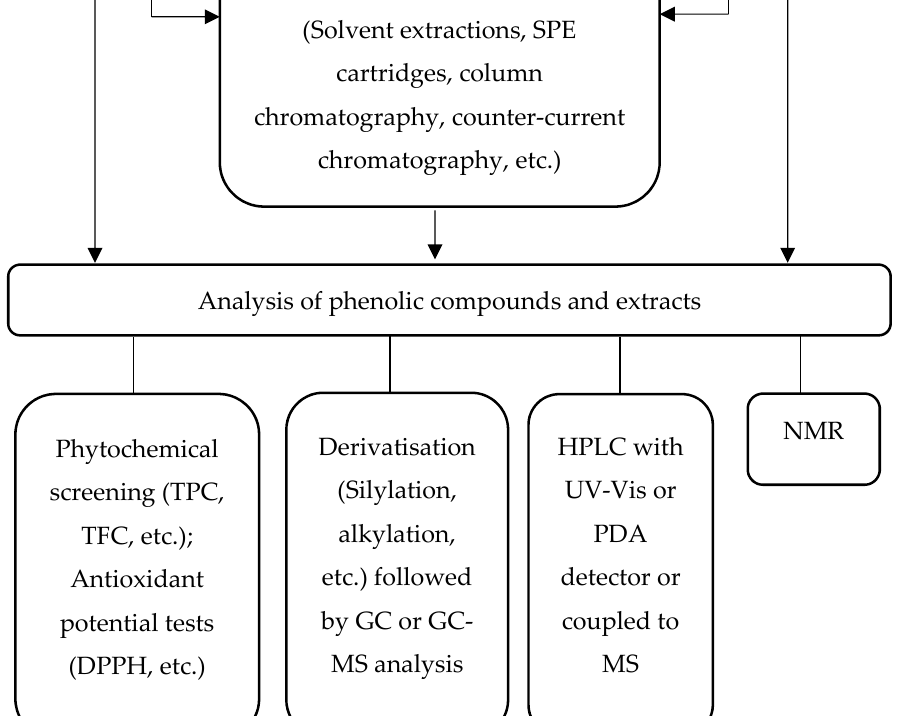
Figure 3. Summary of the characterisation process of phenolic compounds and extracts (UAE ― Ultrasound-Assisted Extraction, MAE ― Microwave-Assisted Extraction, ASE ― Accelerated Solvent Extraction, SWE ― Sub-critical Water Extraction, SFE ― Supercritical Fluid Extraction, HHPE—High Hydrostatic Pressure Extraction, SPE ― Solid Phase Extraction, TPC—Total Phenolic Content, TFC ― Total Flavonoid Content, DPPH ― 2,2-diphenyl-1-picrylhydrazyl (DPPH), GC ― Gas Chromatography, MS ― Mass Spectrometry, HPLC ― High-Performance Liquid Chromatography, UV-Vis—Ultraviolet-Visible, PDA ― Photodiode array, NMR ― Nuclear Magnetic Resonance).